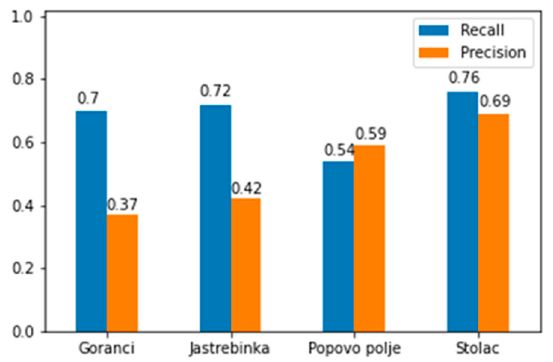
Figure 14. The results of participants in missions without support.